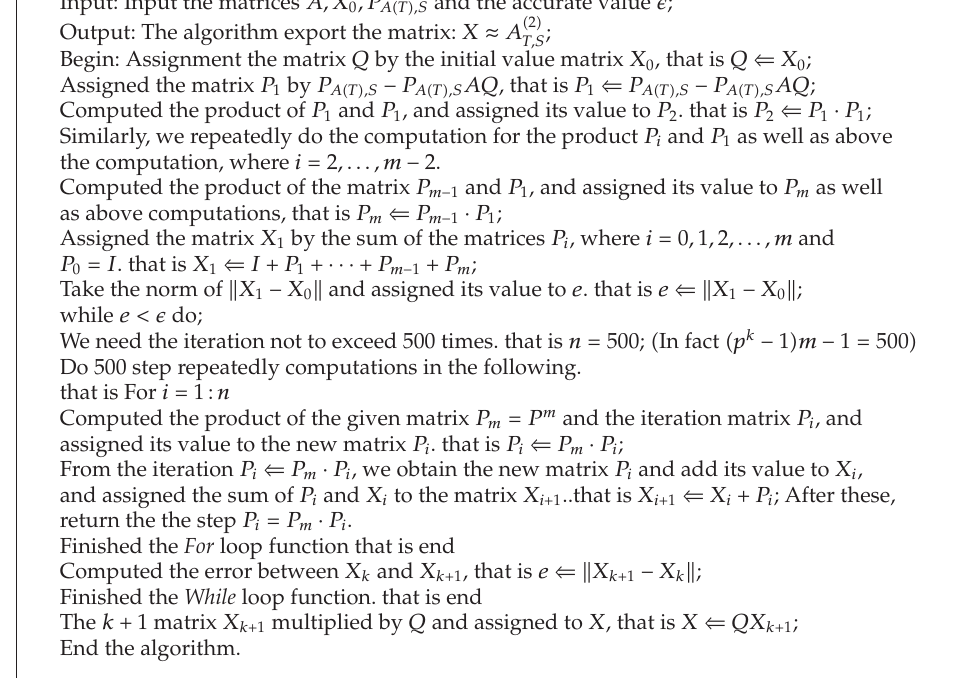
Algorithm 2: SMS algorithm for computing the generalized inverse A